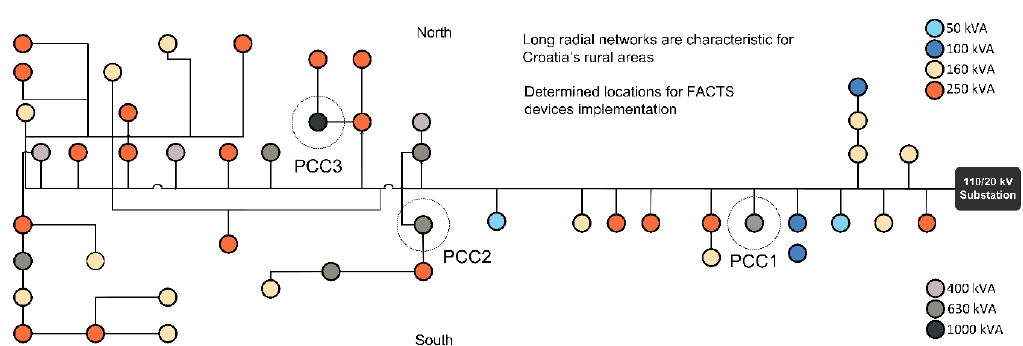
Figure 5. Network model, PCC1 with connected SVC and micro hydroelectric power plant; PCC2 with connected SVC and wind generator; PCC3 with connected SVC and asynchronous motor. The voltage profile of the feeder is observed and the busbars with voltage lower than threshold voltage value (determined by DSO or watchdog agency rules) are taken into consideration. SVC